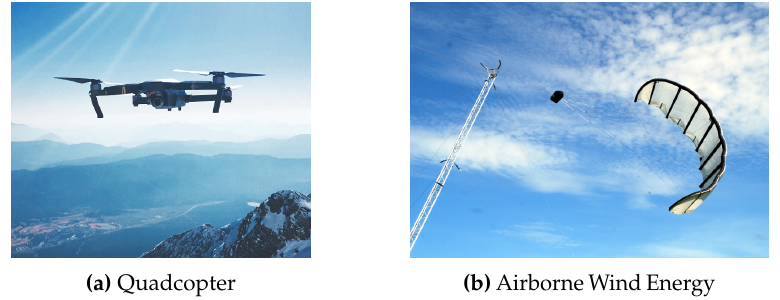
Figure 1. Examples for autonomous airborne applications: ( a ) shows a flying drone (available at https://unsplash.com/photos/ZlkRrzJl20Q, published under CC0, photo by imKirk); ( b ) shows a prototype of an airborne wind energy system developed at TU Delft (http://www.kitepower.eu). Courtesy of Roland Schmehl, TU